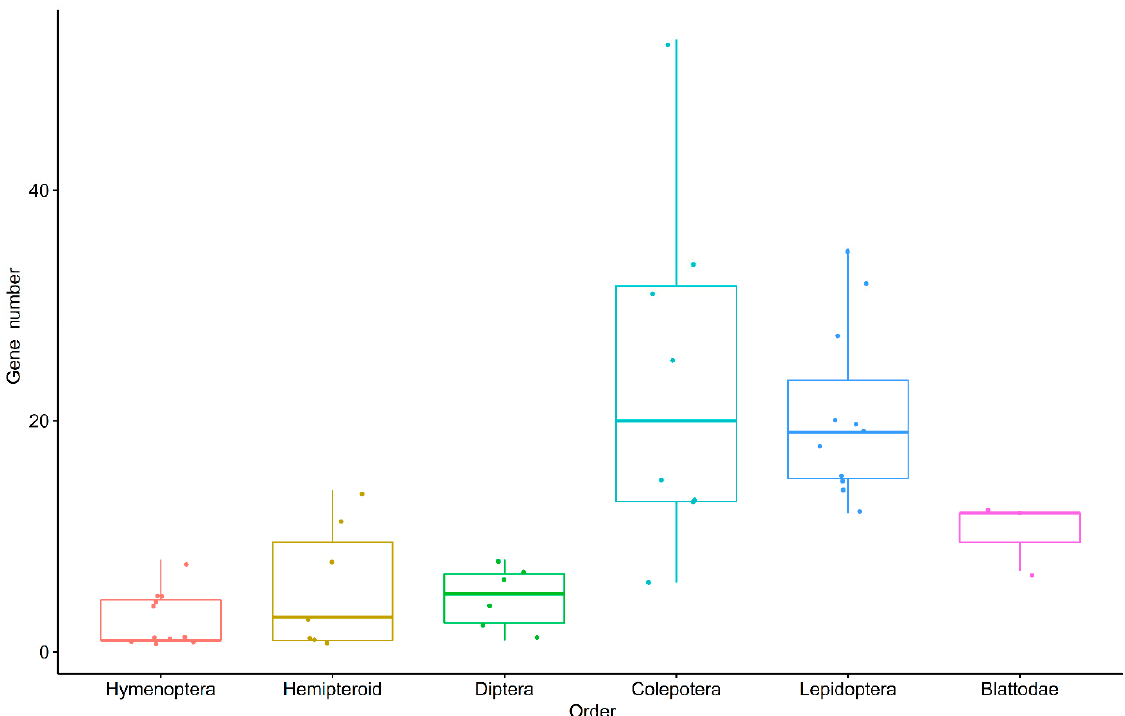
Figure 2. The GH1 gene numbers in each insect order.